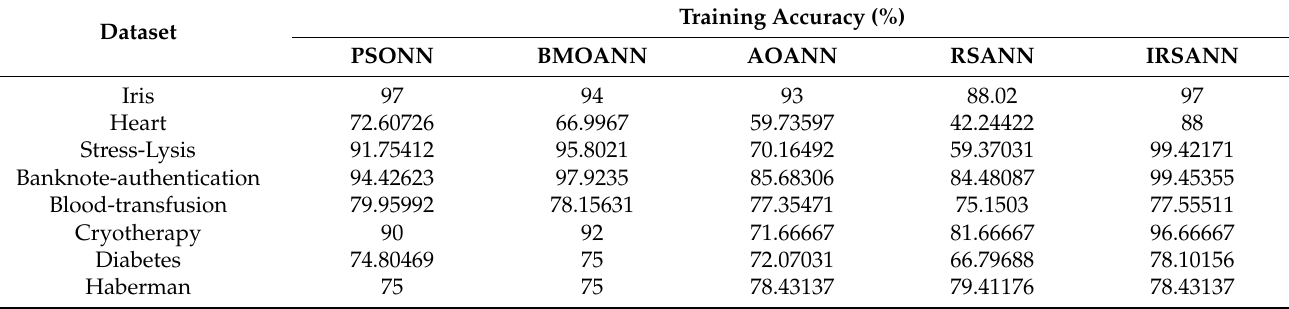
Table 7. Training